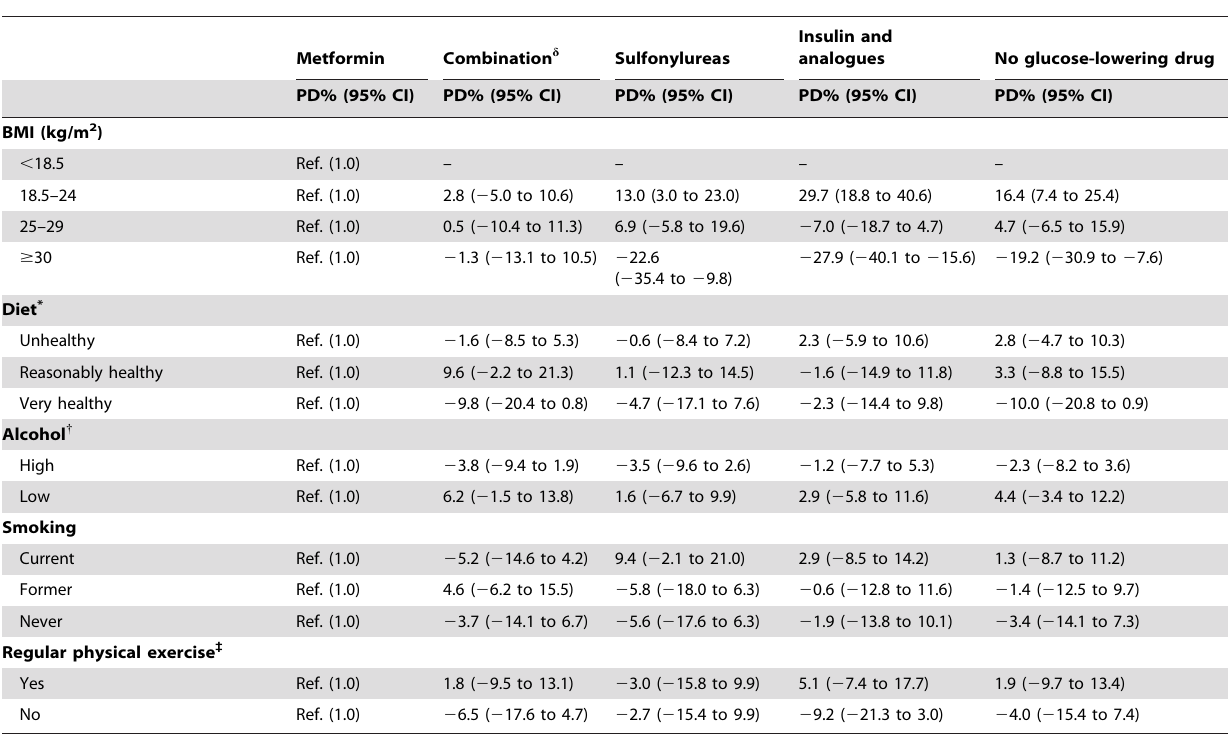
Table 5. Age- and gender-standardized prevalence differences (PDs) of lifestyle factors according to glucose-lowering